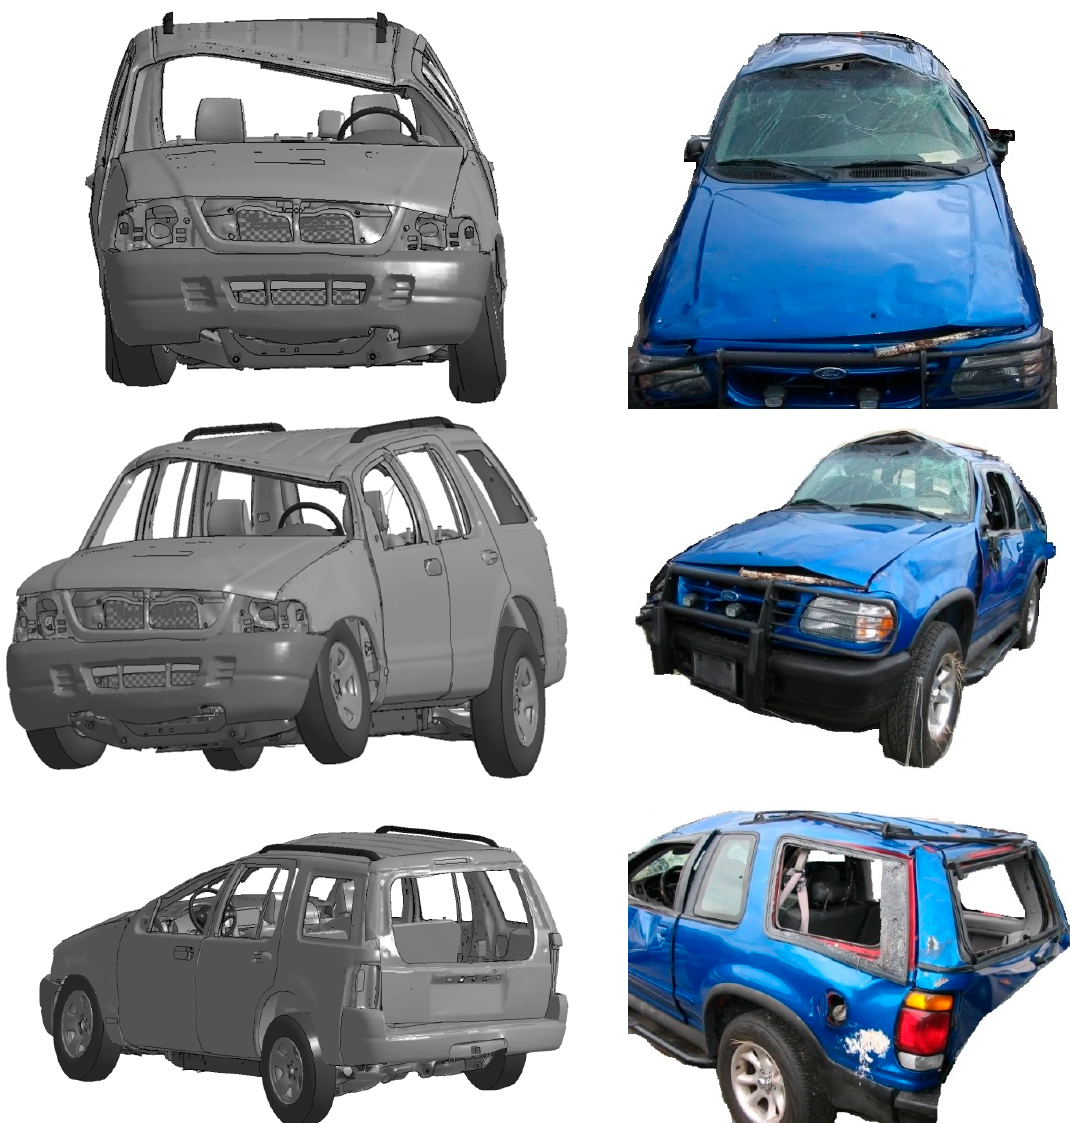
Figure 5. Roof damage of the FE model ( left ) and the case vehicle ( right ).